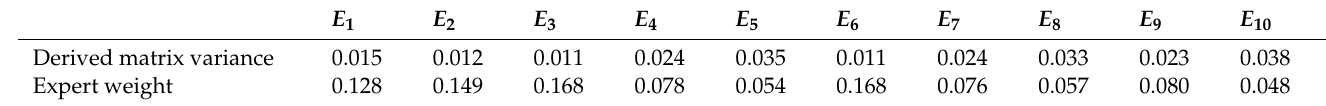
Table 11. Experts’ decision-making capacity weights.